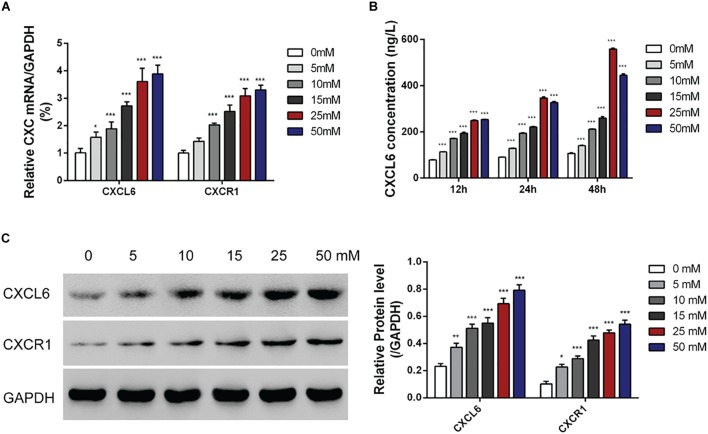
Effect of glucose on the expression of CXCL6 in NRK-49F cells. Cells were cultured with several concentrations of glucose (0, 5, 10, 15, 25, 50 mM) for 12 h, 24 h, and 48 h. CXCL6 expression level in NRK-49F was analyzed by qRT-PCR (A) and WB (B). CXCL6 concentration in NRK-49F cell culture supernatants was measured by Elisa (C). ∗P < 0.05, ∗∗P < 0.01, ∗∗∗P < 0.001.